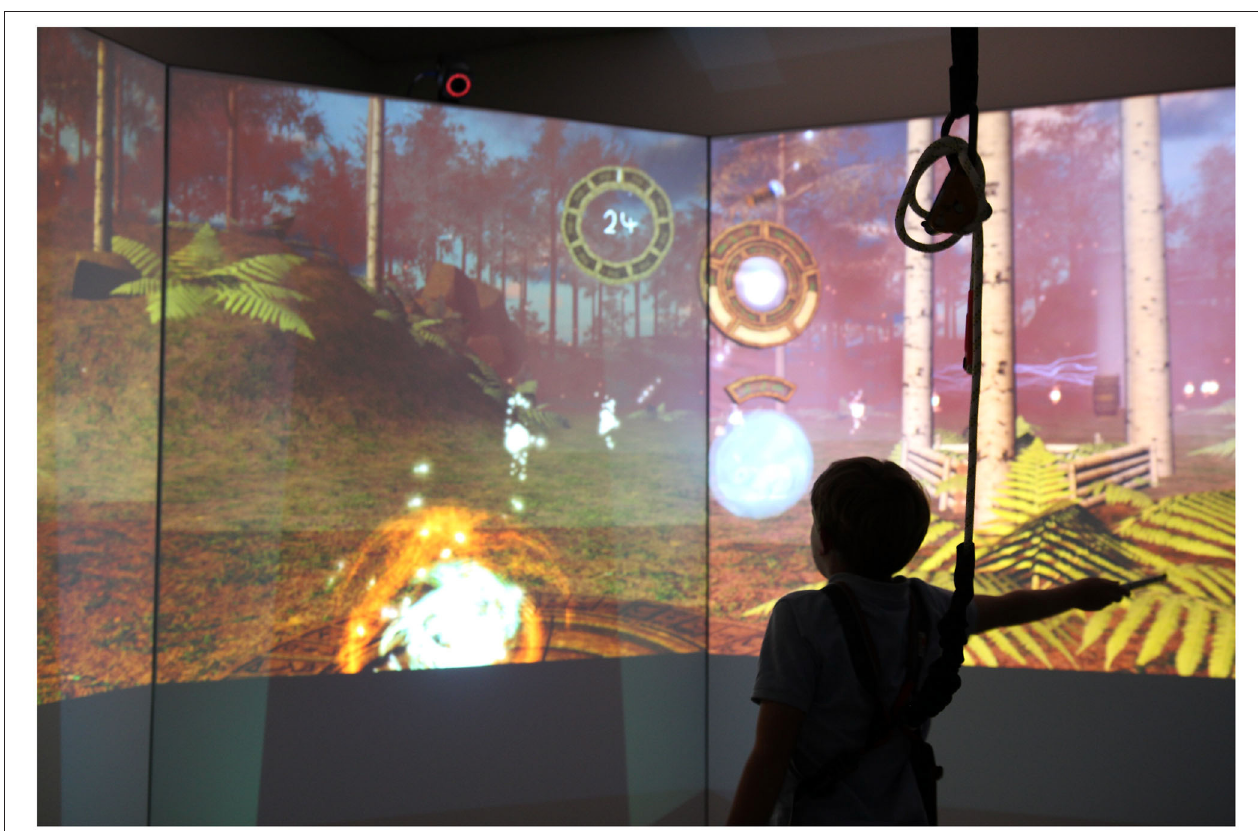
Table 1 provides the mean and SD of z-scores for each age group across sessions and at each session. Table